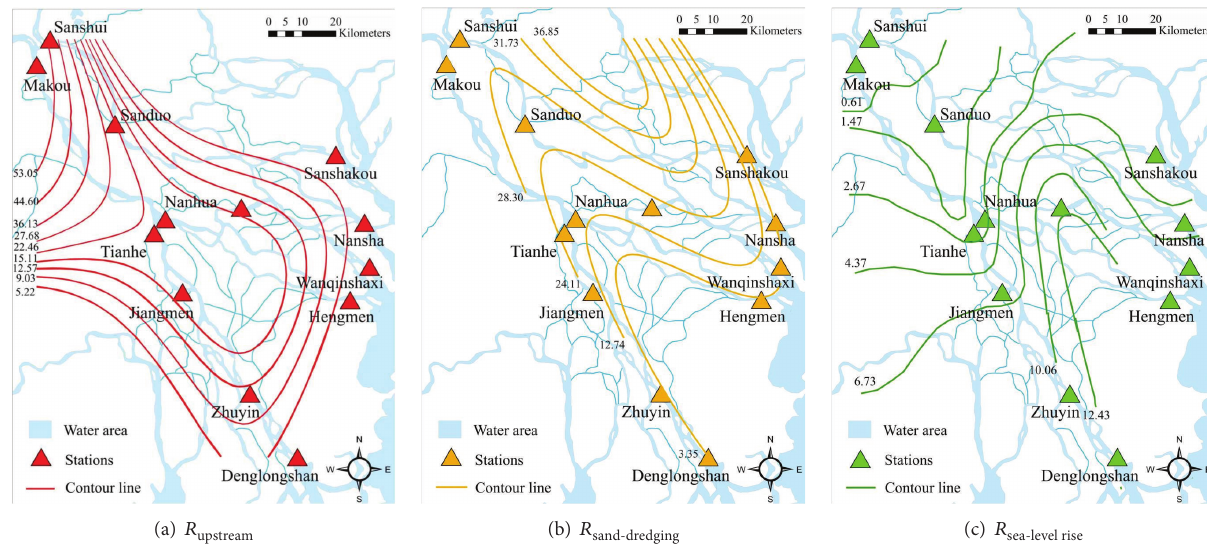
Figure 4: Spatial pattern of 𝑅 .